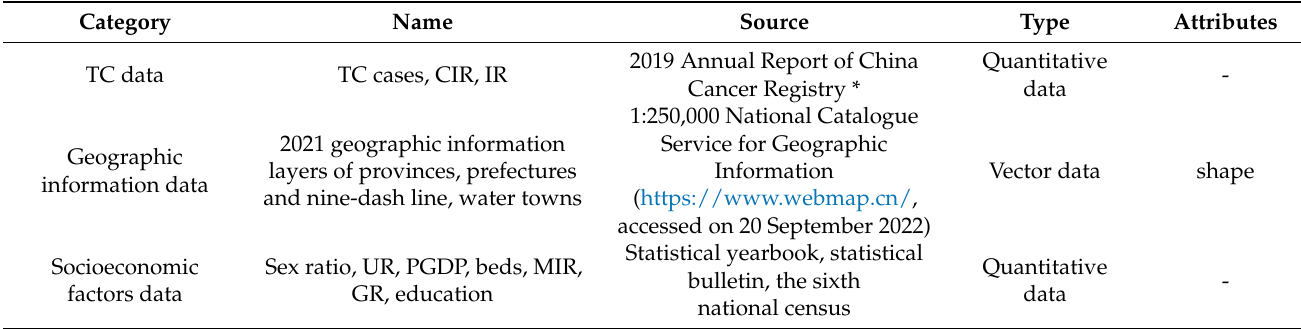
Table 1. Data sources and